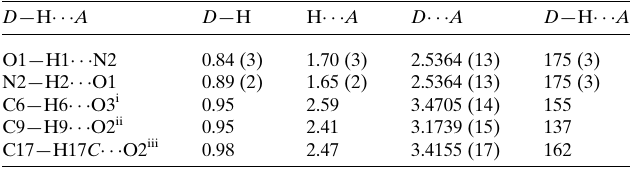
Table 5 Hydrogen-bond geometry (A˚ , (cid:4) ) for (IV).